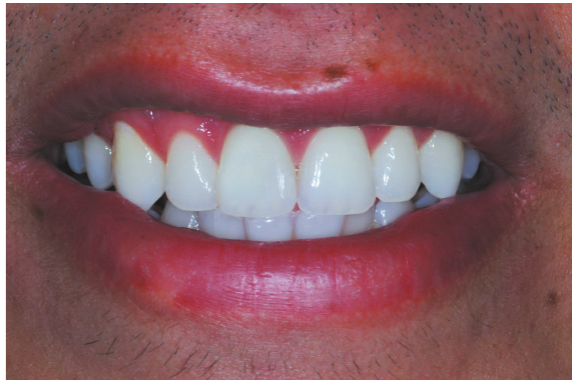
Figure 10- Final esthetic outcome